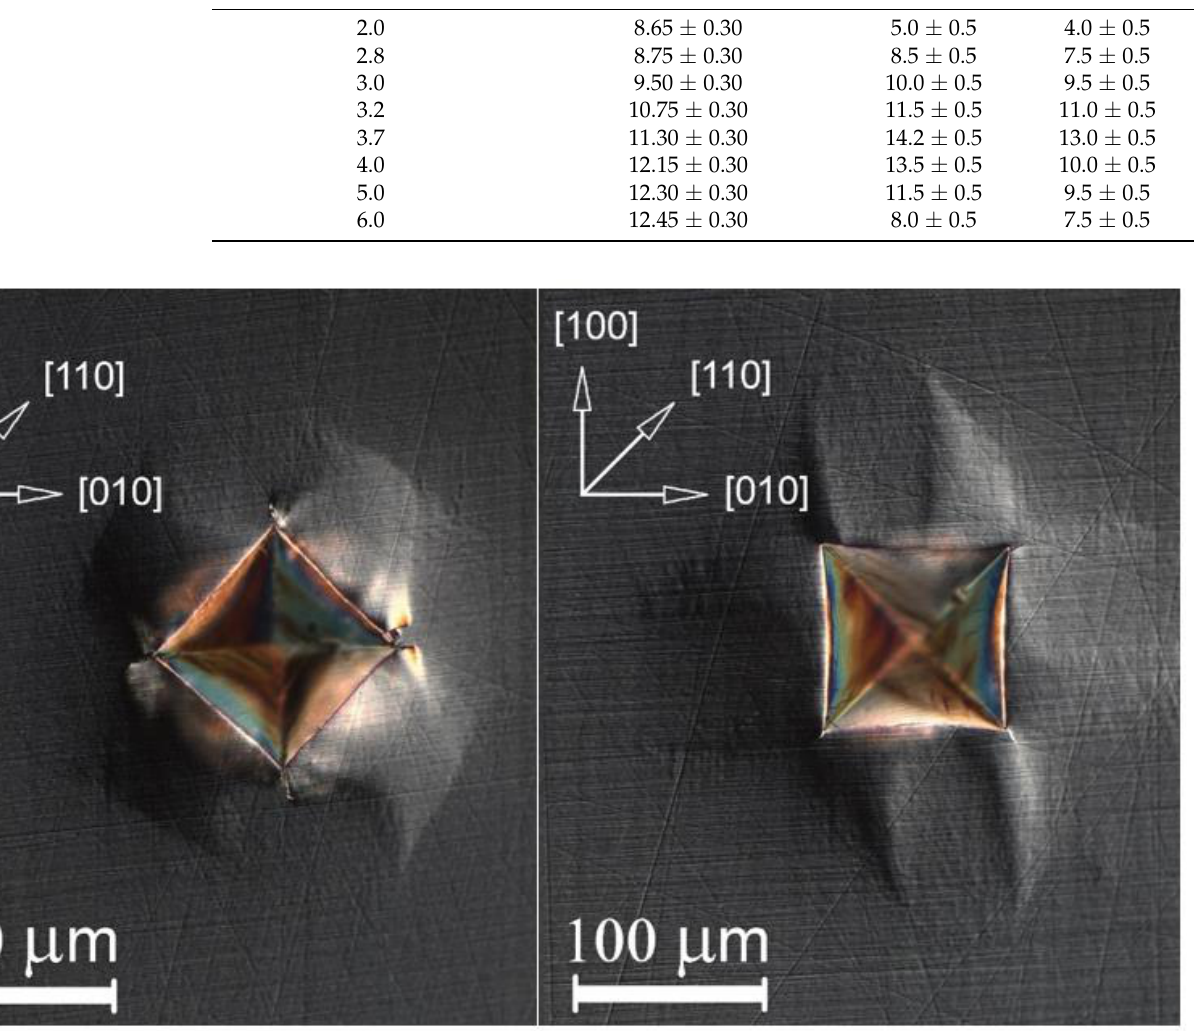
Figure 5. Typical indentations for two different indenter diagonal orientations. (Load 100 N).